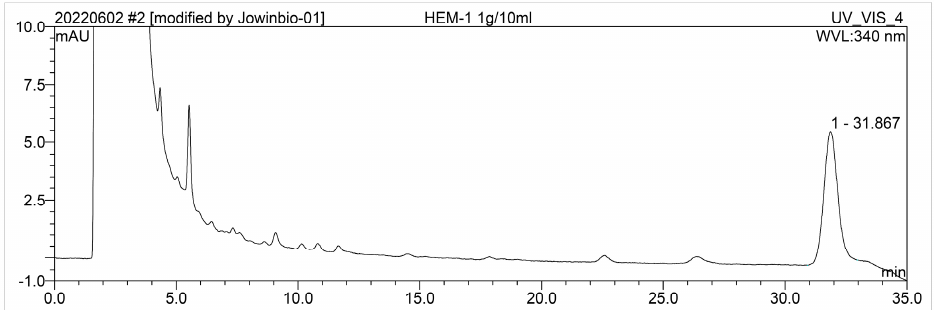
Figure 3. HPLC chromatogram of HEM. The retention time of the diterpenoid erinacine A peak was within the range of 31.000–33.000